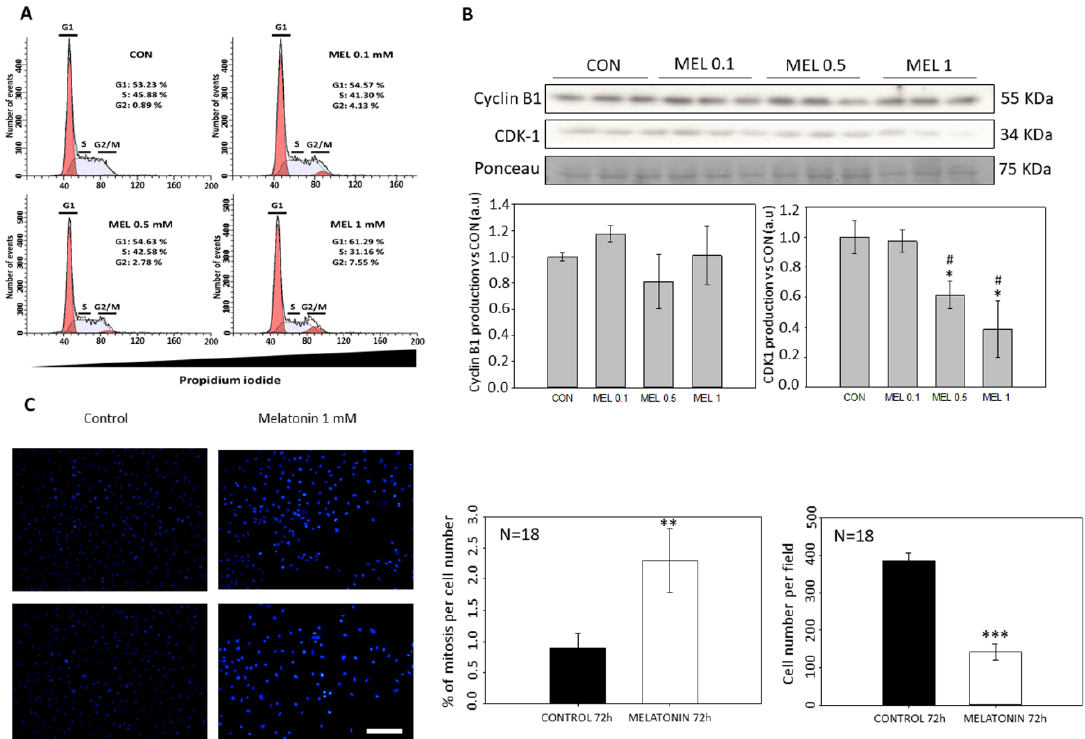
Figure 3. Cell cycle arrest induced by melatonin. ( A ) B16-F10 cells distribution around cell cycle after treatment with different concentrations of melatonin. ( B ) Analysis of proteins involved in G2/M checkpoint. ( C ) Percentage of mitosis per cell number in control and treatment group. Blue dots represent nuclear staining of DNA with DAPI. Significance vs. CON. * P < 0.05, ** P < 0.01, *** P < 0.001. Significance vs. MEL 0.1. # P < 0.05. Image Scale bar = 100 μ m.